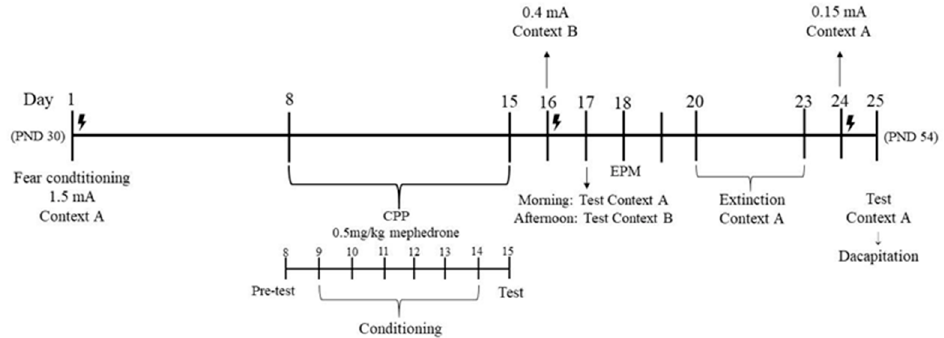
Figure 1. Experimental design.